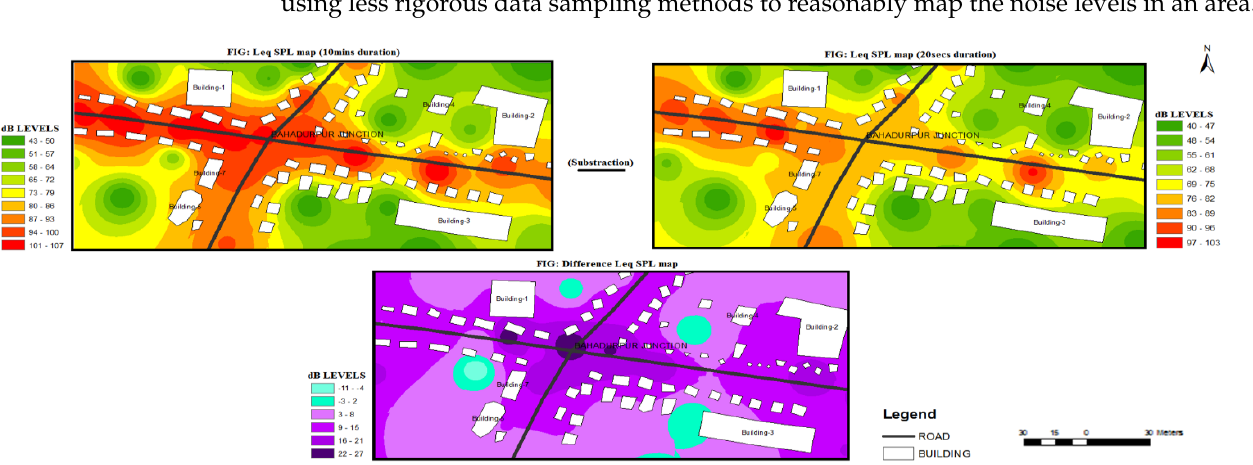
time interval (7–9am) for the Bahadurpur study area. time interval (7:00–9:00 a.m.) for the Bahadurpur study area.